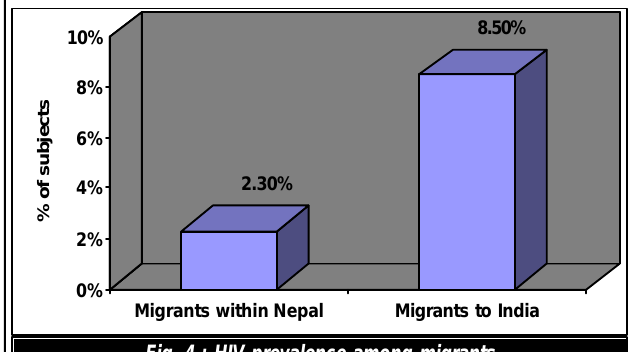
Fig. 4 : HIV prevalence among